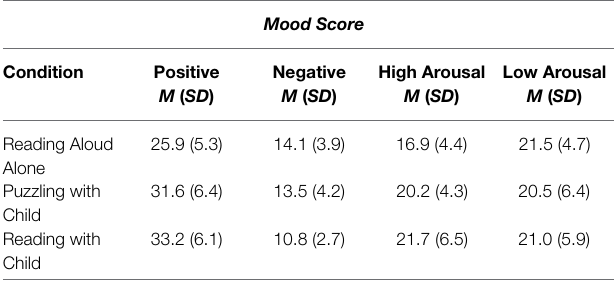
TABLE 1 | Postsession Mood Scores for Each Condition in Experiment